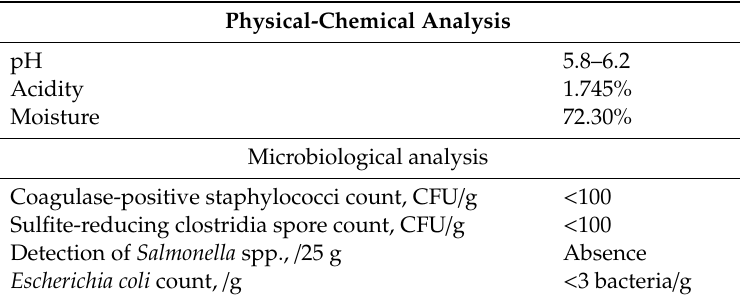
Table 4. Physical-chemical and microbiological analyses for pork.